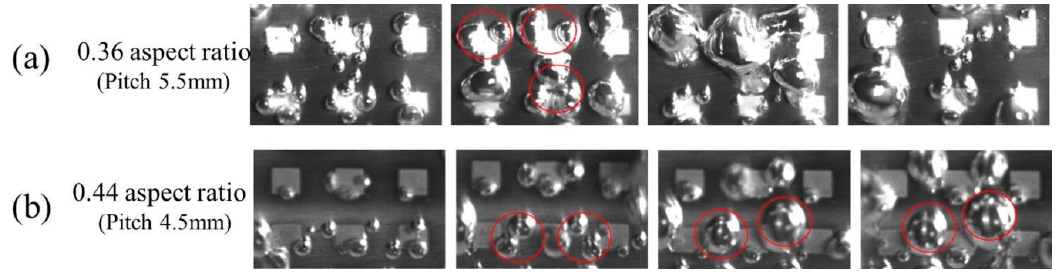
Figure 13. Bubble development mechanisms of the surfaces with ( a ) 0.36 aspect ratio and ( b ) 0.44 Figure 13. aspect ratio.